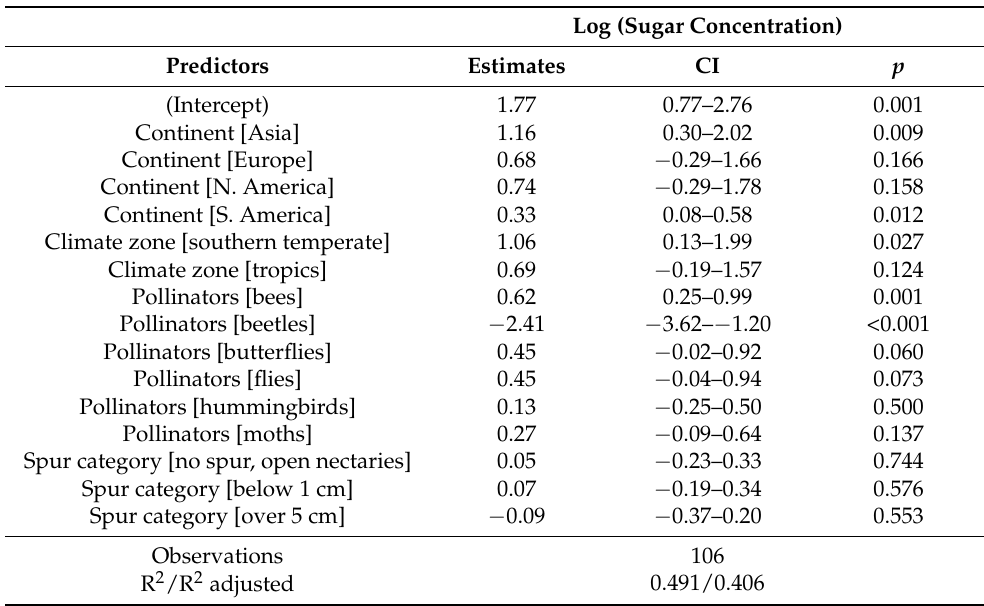
Table 1. Results of the most-supported linear model explaining the logarithm of sugar concentration in